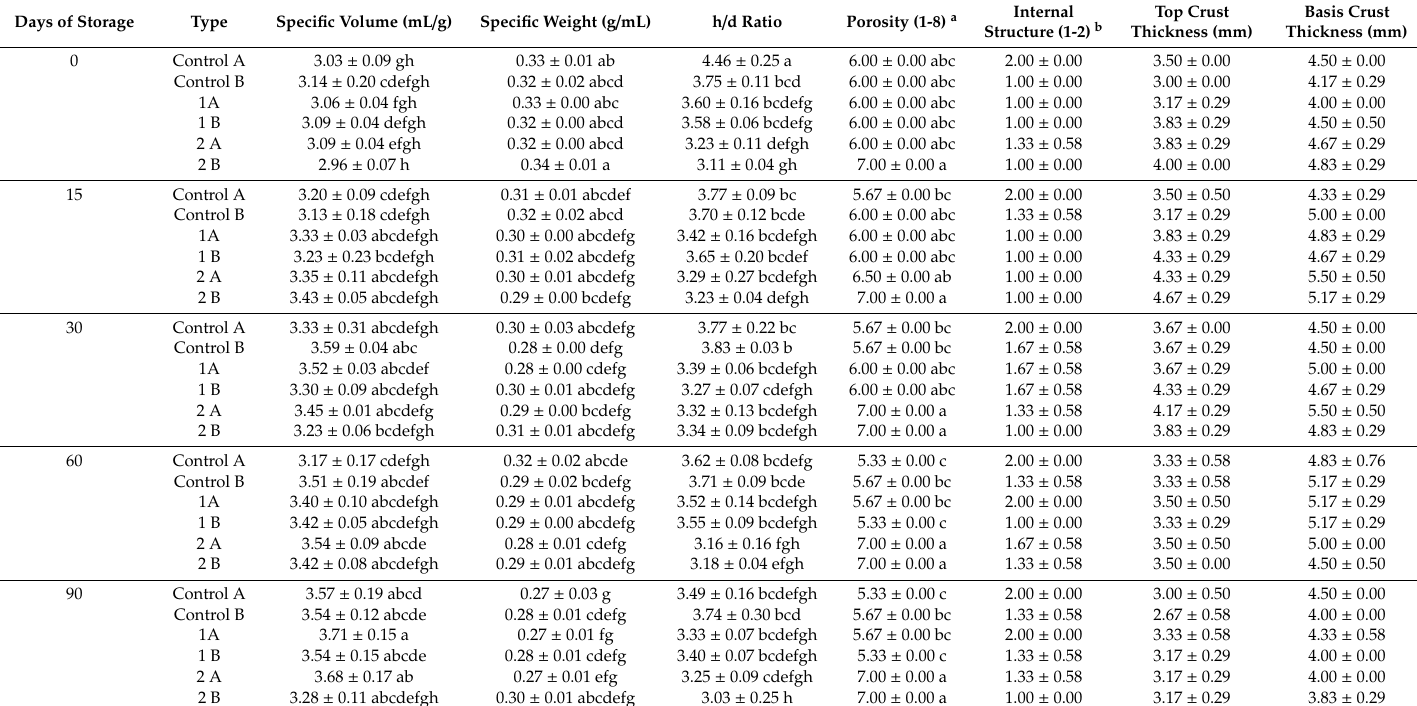
Table 5. Evaluation of physical properties during storage of the bread samples produced using different types and levels of sea salt (data are means ± standard